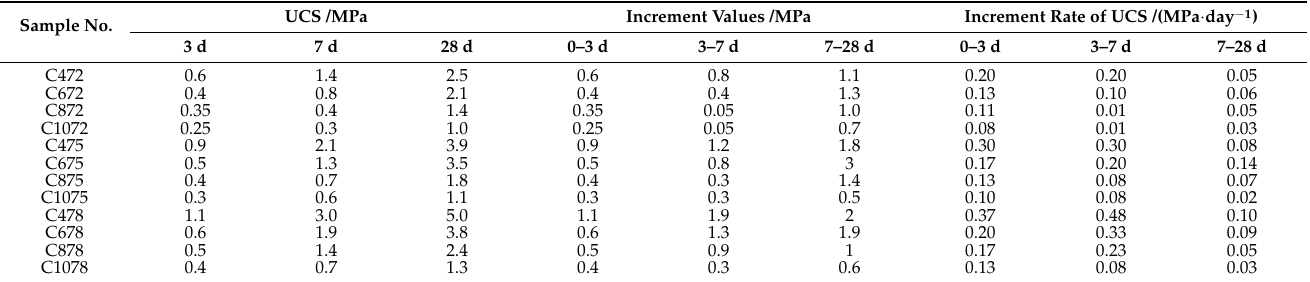
Table 5. Strength increment rates of CTB samples within different curing